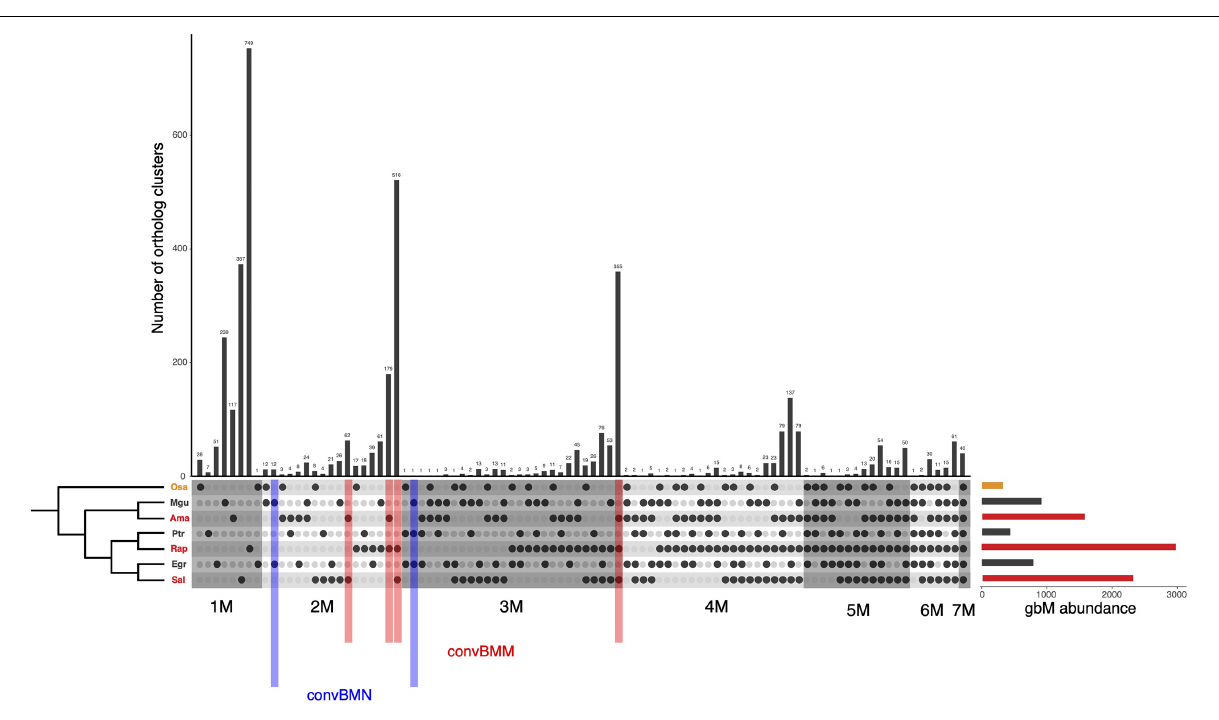
FIGURE 3 | Conservation of gbM status across orthologs of the three mangroves and their non-mangrove relatives. The UpSetR plot shows all intersecting sets of the gbM status between species examined. The number of genes in each intersecting set is given at the top of the histogram. In each species, the gbM status is indicated with filled or open circle for BM and UM genes, respectively. Orthologous genes were grouped by their conservation of gbM and labeled from 1 to 7 plus “M,” indicating the number of species where the gbM status is conserved. Bar plot displays the abundance of BM genes in each species. convBMM, BM genes with convergence of gbM specific to mangroves; convBMN, BM genes with convergence of gbM specific to non-mangroves. Osa, Oryza sativa ; Mgu, Mimulus guttatus ; Ptr, Populus trichocarpa ; Egr, Eucalyptus grandis ; Ama, Avicennia marina ; Rap, Rhizophora apiculata ; Sal, Sonneratia alba